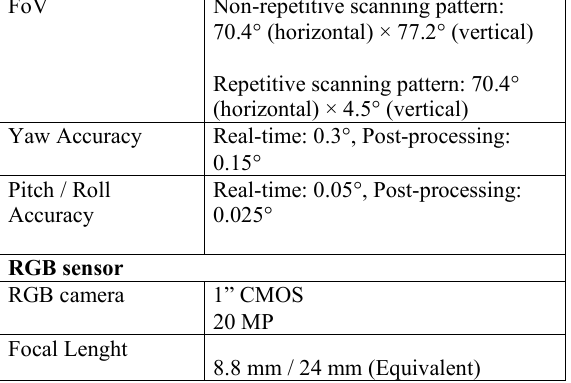
Table 1. DJI Zenmuse L1 main specifications. Full specifications